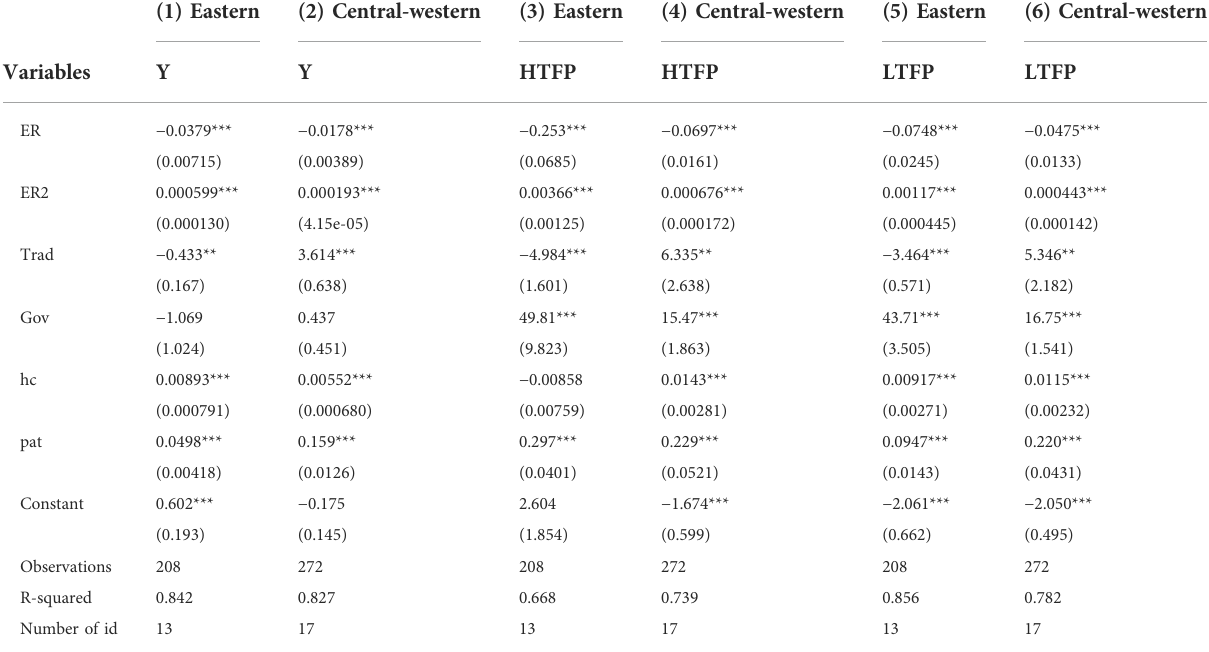
TABLE 7 Regression Results of Regional Model (1) and